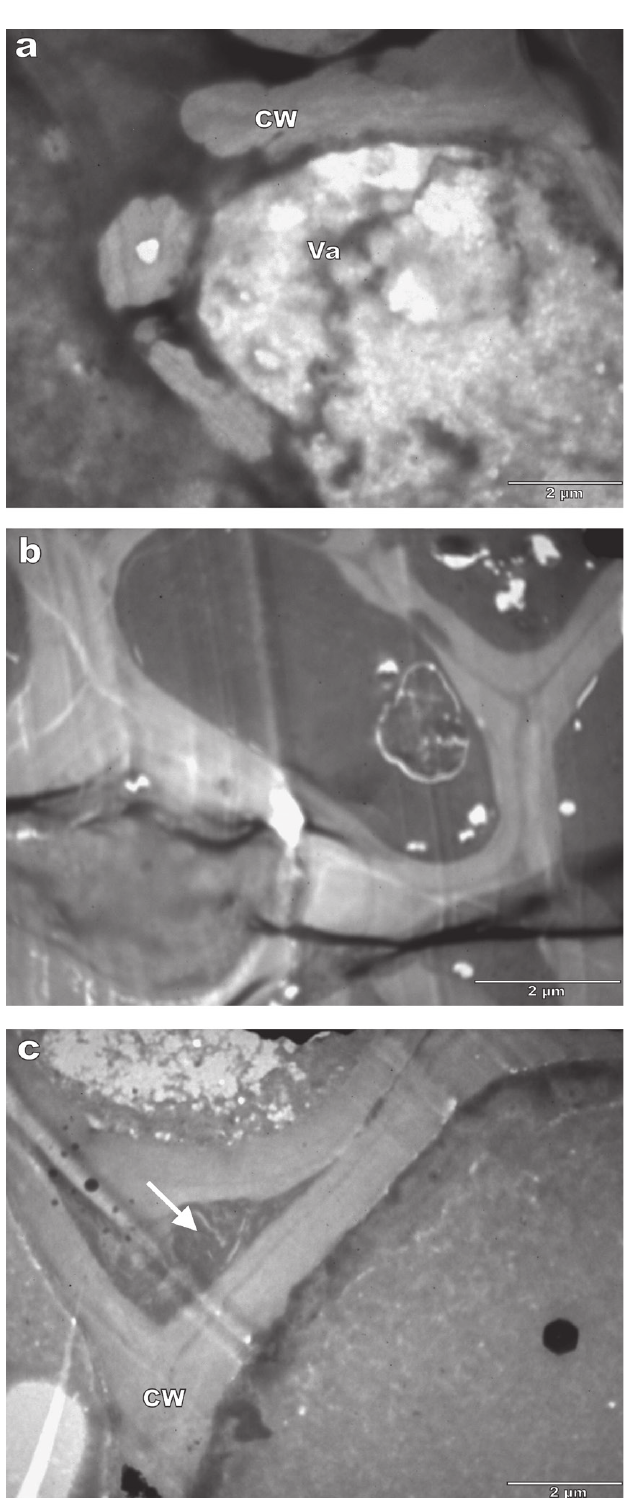
Figure 5 - Transmission electron micrographs of the callus Type 1 A) Large vacuole, narrow cytoplasm and cell wall rupture (arrows). B) Cells. C) Large intercellular spaces (arrows), cell wall (CW) and large vacuole